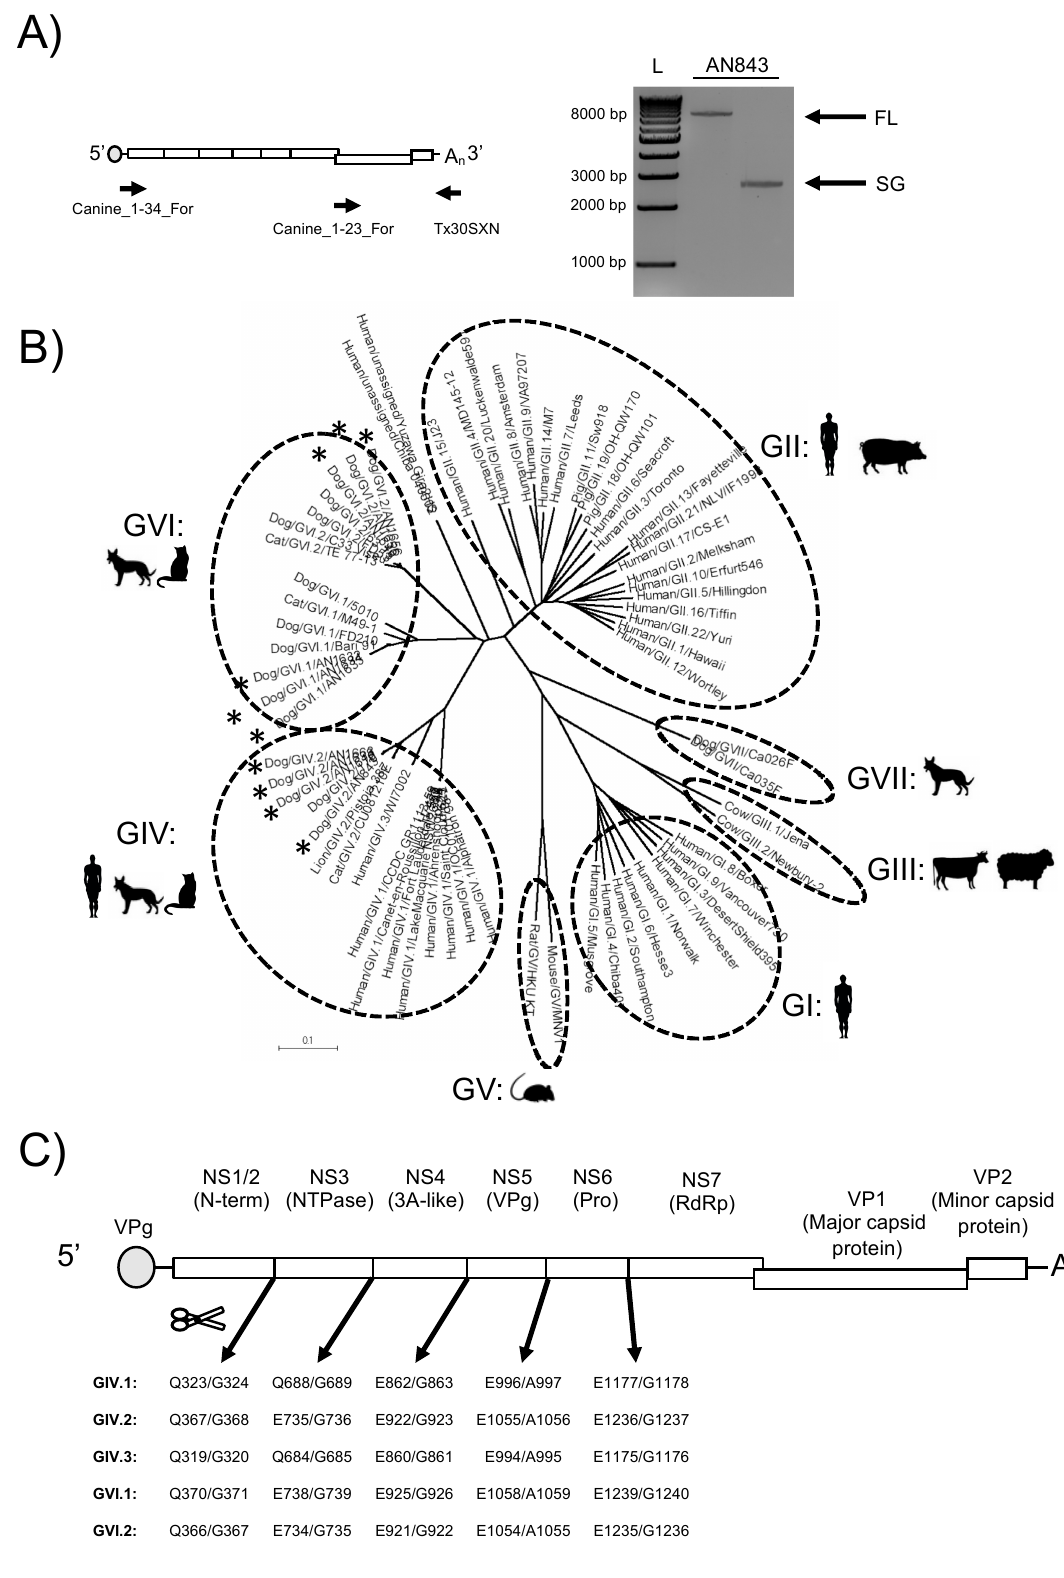
Figure 1. Amplification and characterization of novel canine norovirus strains. ( A ) Scheme used to amplify nearly full-length (FL) genome and the subgenomic (SG) region (left). The primers used for amplification are represented by arrows below the genome. Electrophoresis gels showing amplicons obtained from FL and SG RT-PCR from a representative sample (right). L = 1 kb ladder. ( B ) Phylogenetic analyses of norovirus major capsid protein (VP1) from representative strains from each genogroup. Phylogenetic tree of the complete aa sequence of VP1 based on the Neighbor